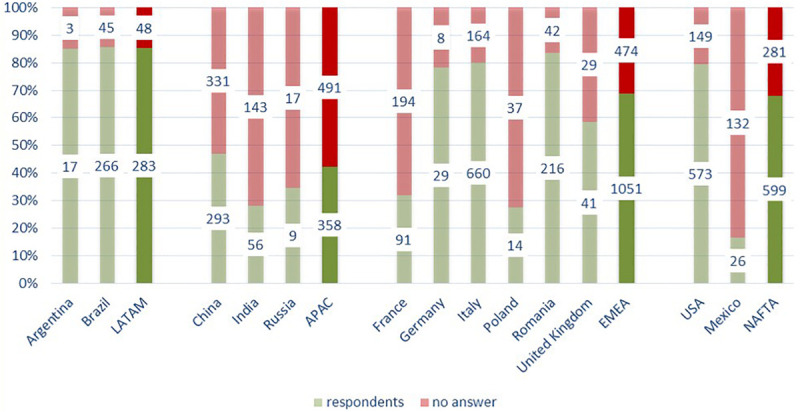
Participation rate.